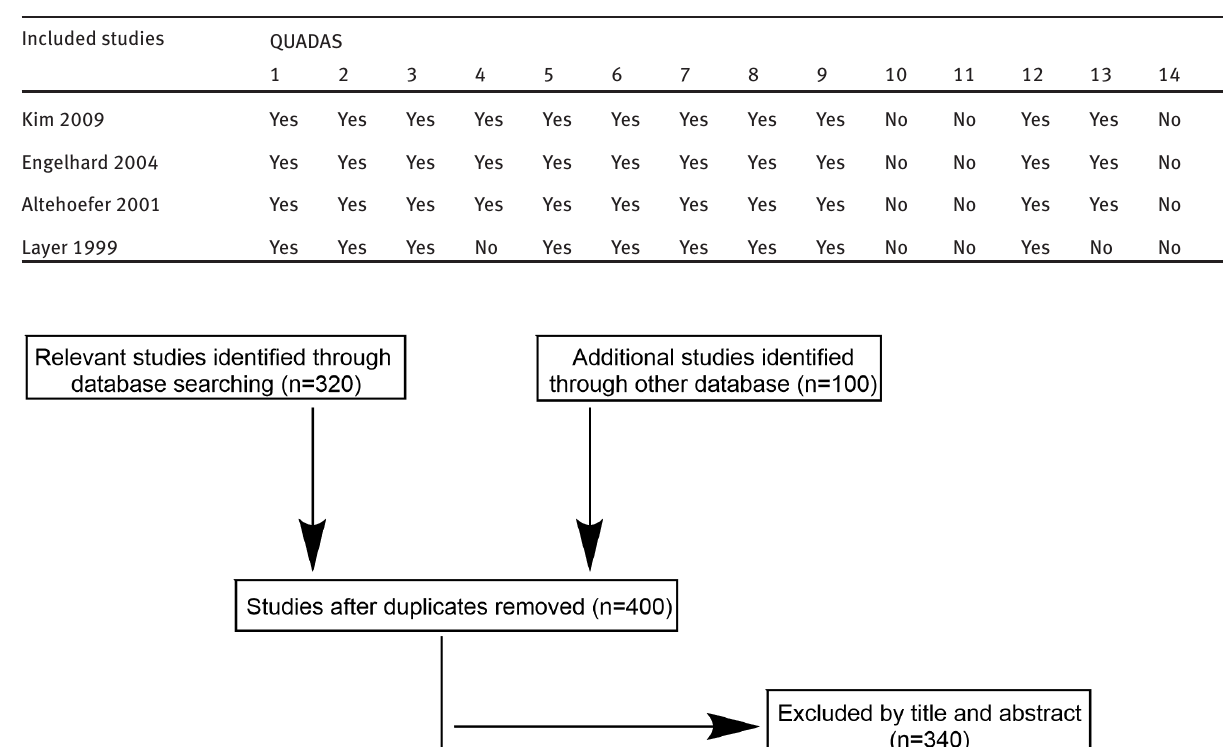
Table 2: Quality assessment of included studies